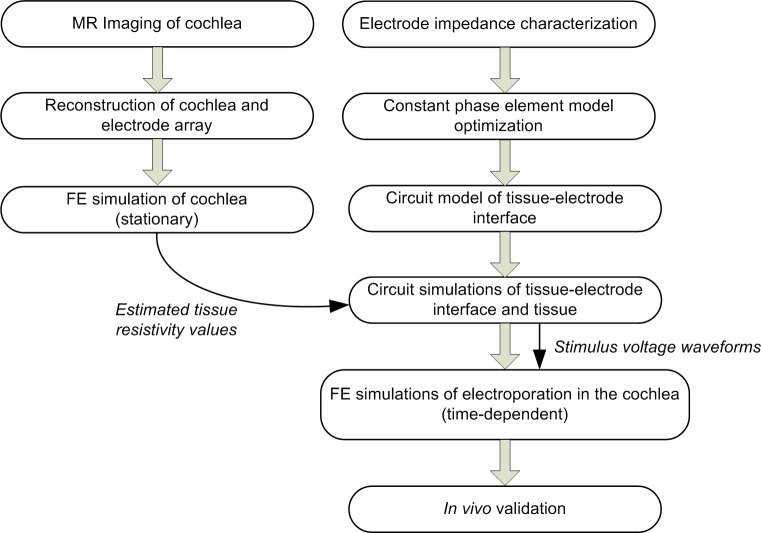
Modeling workflow.